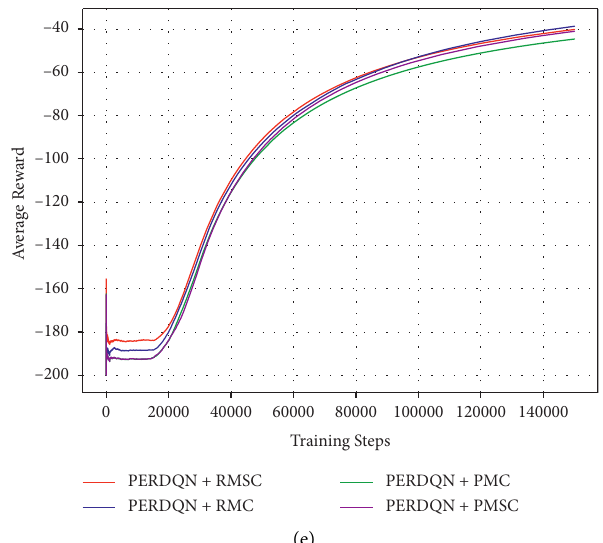
Figure 4: Average reward of PERDQN and DQN among training steps under different schemes in case 1. (a) Average reward under scheme 1. (b) Average reward under scheme 2. (c) Average reward under scheme 3. (d) Average reward under scheme 4. (e) Average reward comparison of PERDQN among four schemes.